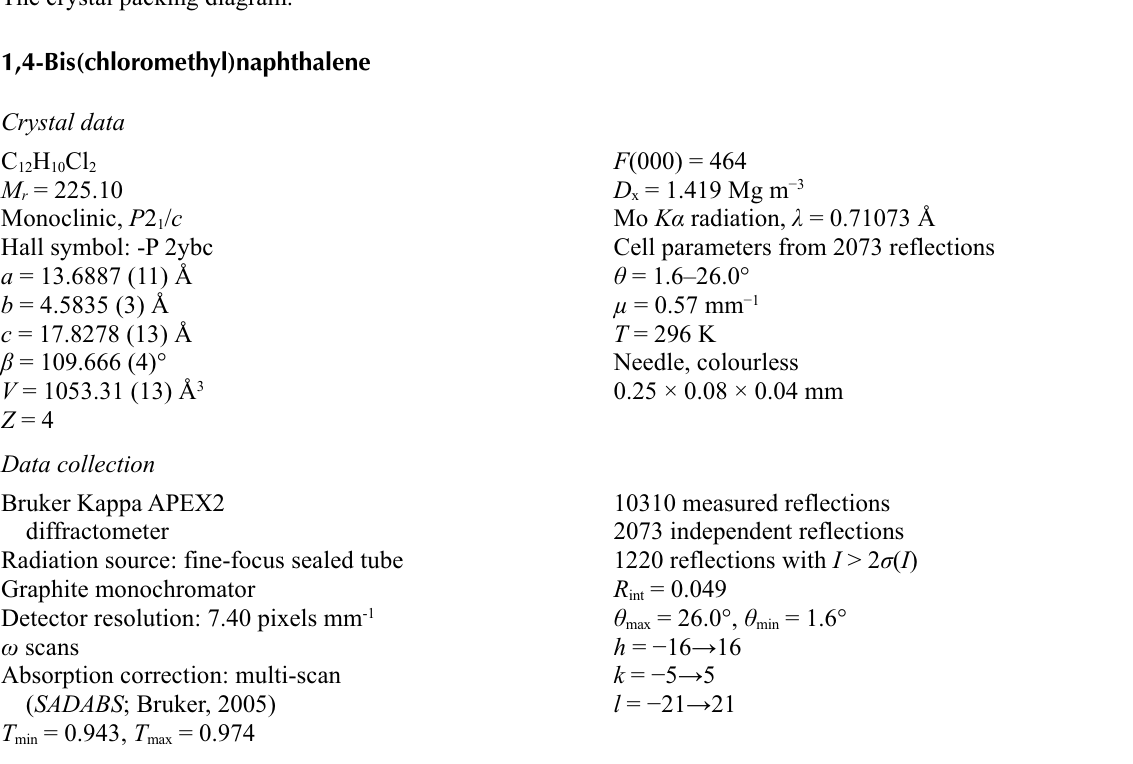
Figure 2 The crystal packing